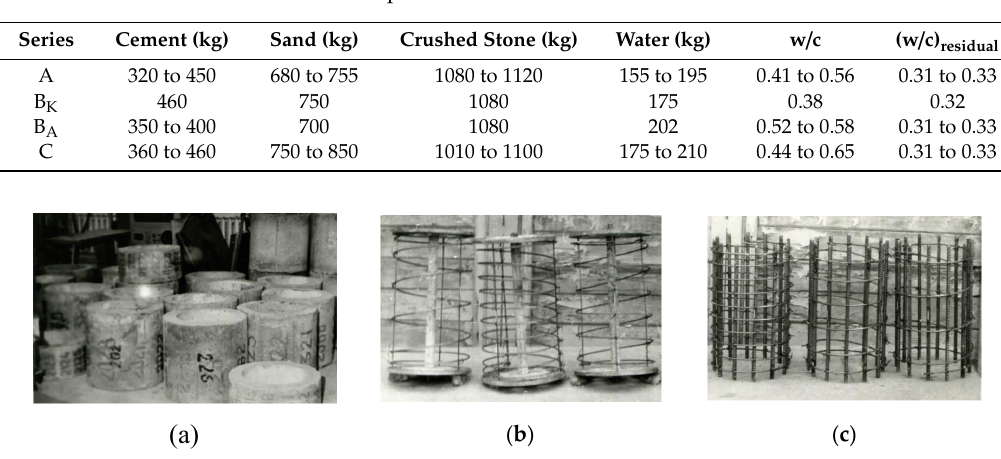
Figure 1. ( a ) Manufactured concrete and reinforced concrete specimens of centrifuged concrete and ( b , c ) reinforcement